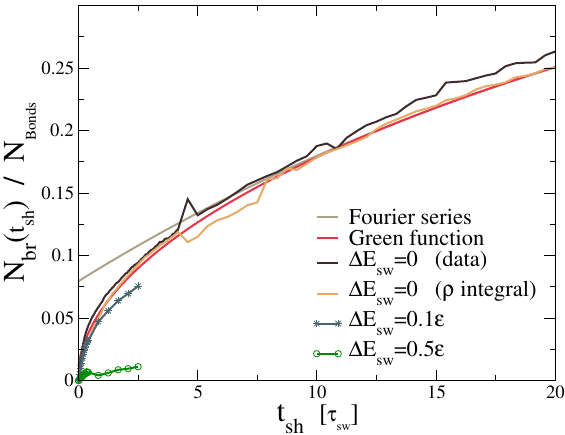
Figure 6. Actual number of bridges (black) compared to the estimation of Equation (2) evaluated from the numerical simulations (orange), Fourier series (gray), and Green function (red). The Fourier and Green function curves use the previously fitted value D = 3.12 σ 2 / τ sw , which represents the case of bond-swap without energy barriers. The plotted quantity should approach the limit of 0.5 upon full mixing, which happens well beyond the limit of our simulations (see Figure 5). A barrier of ∆ E sw = 0.5 ε is already enough to undermine the bridge formation. The gray curve is a truncated Fourier series that only takes into account the three slowest modes and is therefore not expected to match well at short